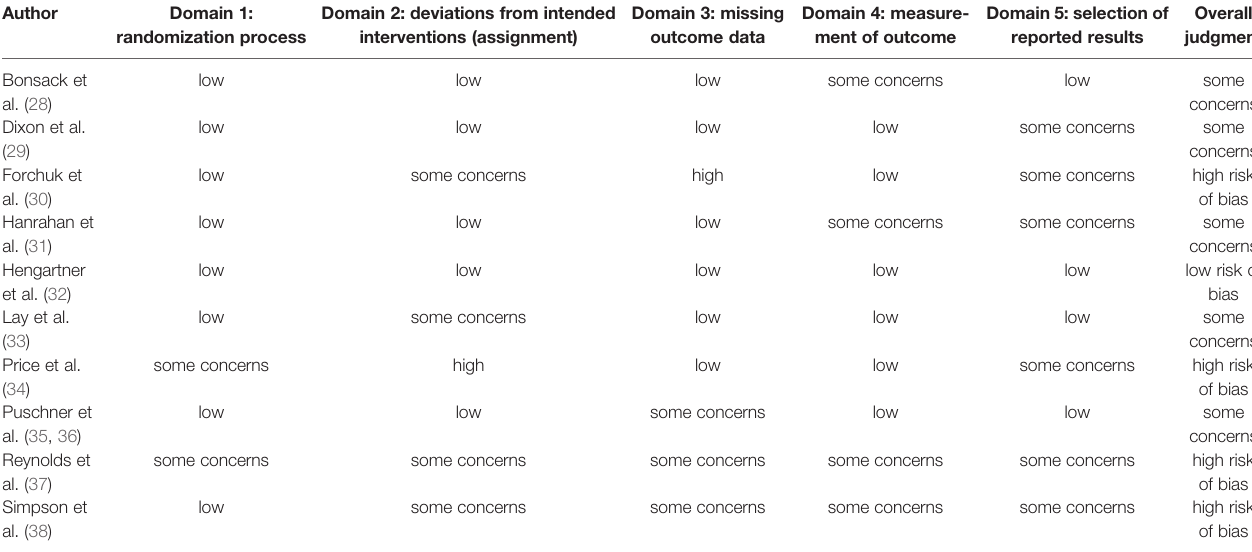
TABLE 2 | Quality assessment of randomized controlled studies using the Revised Cochrane Risk-of-Bias tool for randomized trials (26).